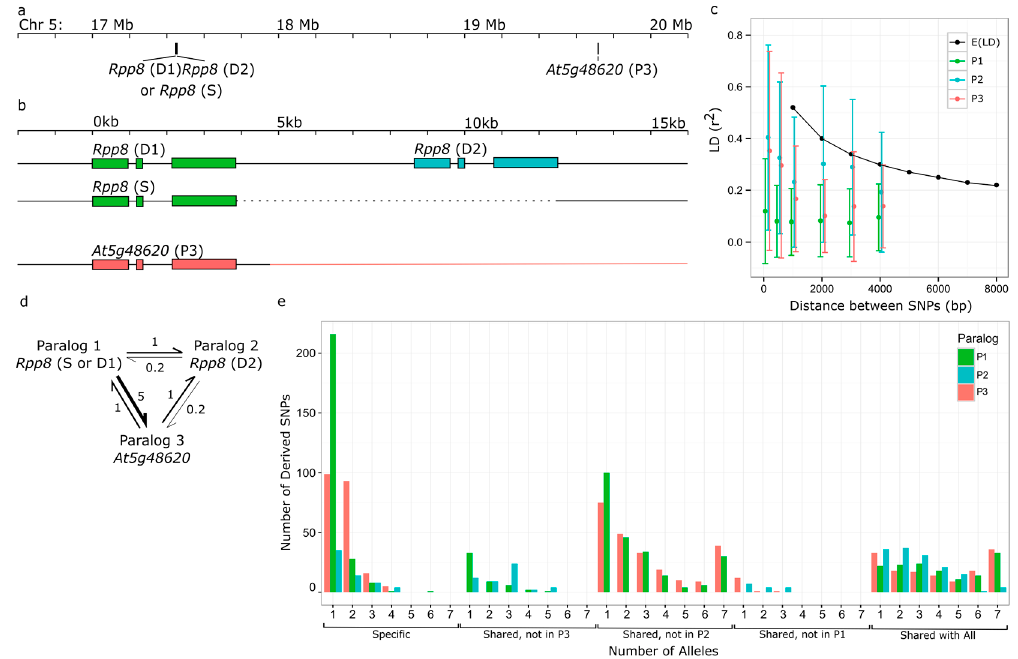
Figure 1. Signatures of intergenic gene conversion (IGC) in the RPP8 gene family in Arabidopsis thaliana . RPP8 refers to the entire gene family, including all three paralogs. D1,D2 and S refer to specific chromosomal types. P1, P2, and P3 refer to specific paralogs, and green, blue, and orange represent P1, P2, and P3, respectively. ( a ) Positions of the coding sequence of RPP8 and At5g48620 (P3) on chromosome 5. ( b ) Homology of loci in the RPP8 gene family. Positions are shown in kilobases, relative to the start codon of the first paralog at that chromosomal location. Exons of RPP8 loci are shown as boxes; dashed line indicates deleted regions; orange line indicates regions of P3 with no paralogy to P1 or P2. ( c ) Expected and observed linkage disequilibrium (LD) decay from [50] and in three RPP8 paralogs. ( d ) Schematic of IGC rate estimates and directionality between RPP8 paralogs most consistent with the SFS and LD results from ( c , e ), and Figures S5–S7. ( e ) Modified site frequency spectrum (SFS) between all three RPP8 paralogs. Plot shows the frequencies of derived SNPs specific to a paralog or shared with one or both other paralogs.